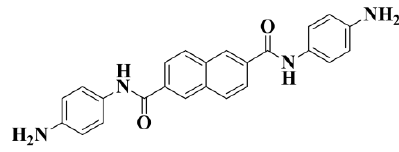
Figure 1. Structural formula of